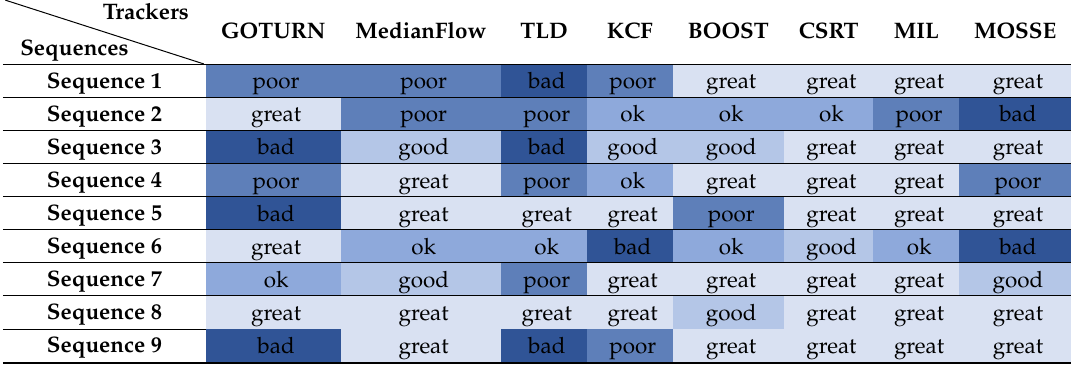
Table 3. Overall accuracy comparison of eight trackers on nine video sequences (bad: 0~20%;